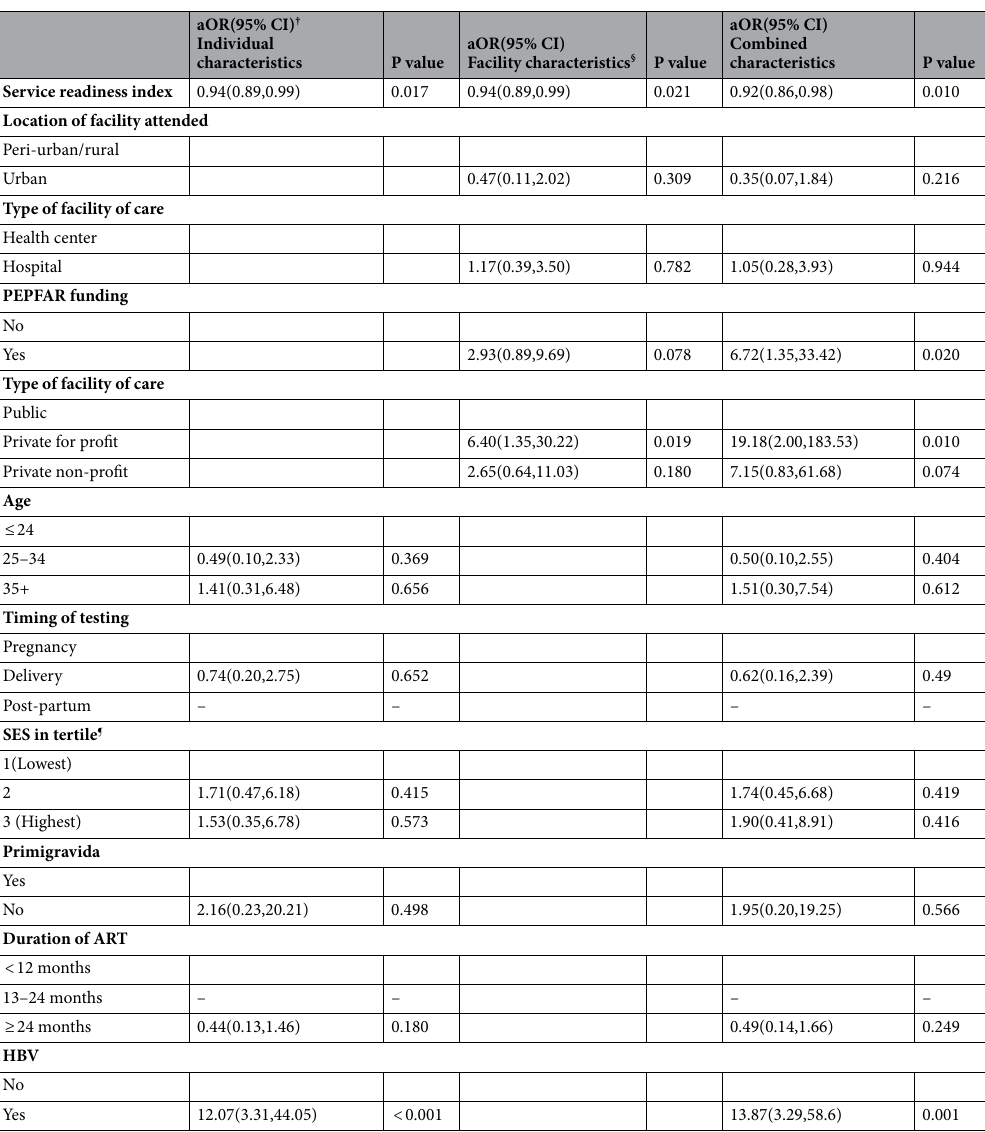
Table 3. Multivariable associations between sociodemographic, clinical and facility characteristics of the study population. The analytical sample was derived from the enrollment data of an ongoing cluster randomized controlled trial, aimed at evaluating the effect of data-driven continuous quality improvement on long-term ART outcomes in Kinshasa, Democratic Republic of Congo. We retained participants that had available data on HCV rapid testing. SES, socio-economic status; RNA, ribonucleic acid; ART, antiretroviral therapy; HBV, hepatitis B virus; uOR, unadjusted odds ratio; aOR, adjusted odds ratio; 95%CI, 95% confidence